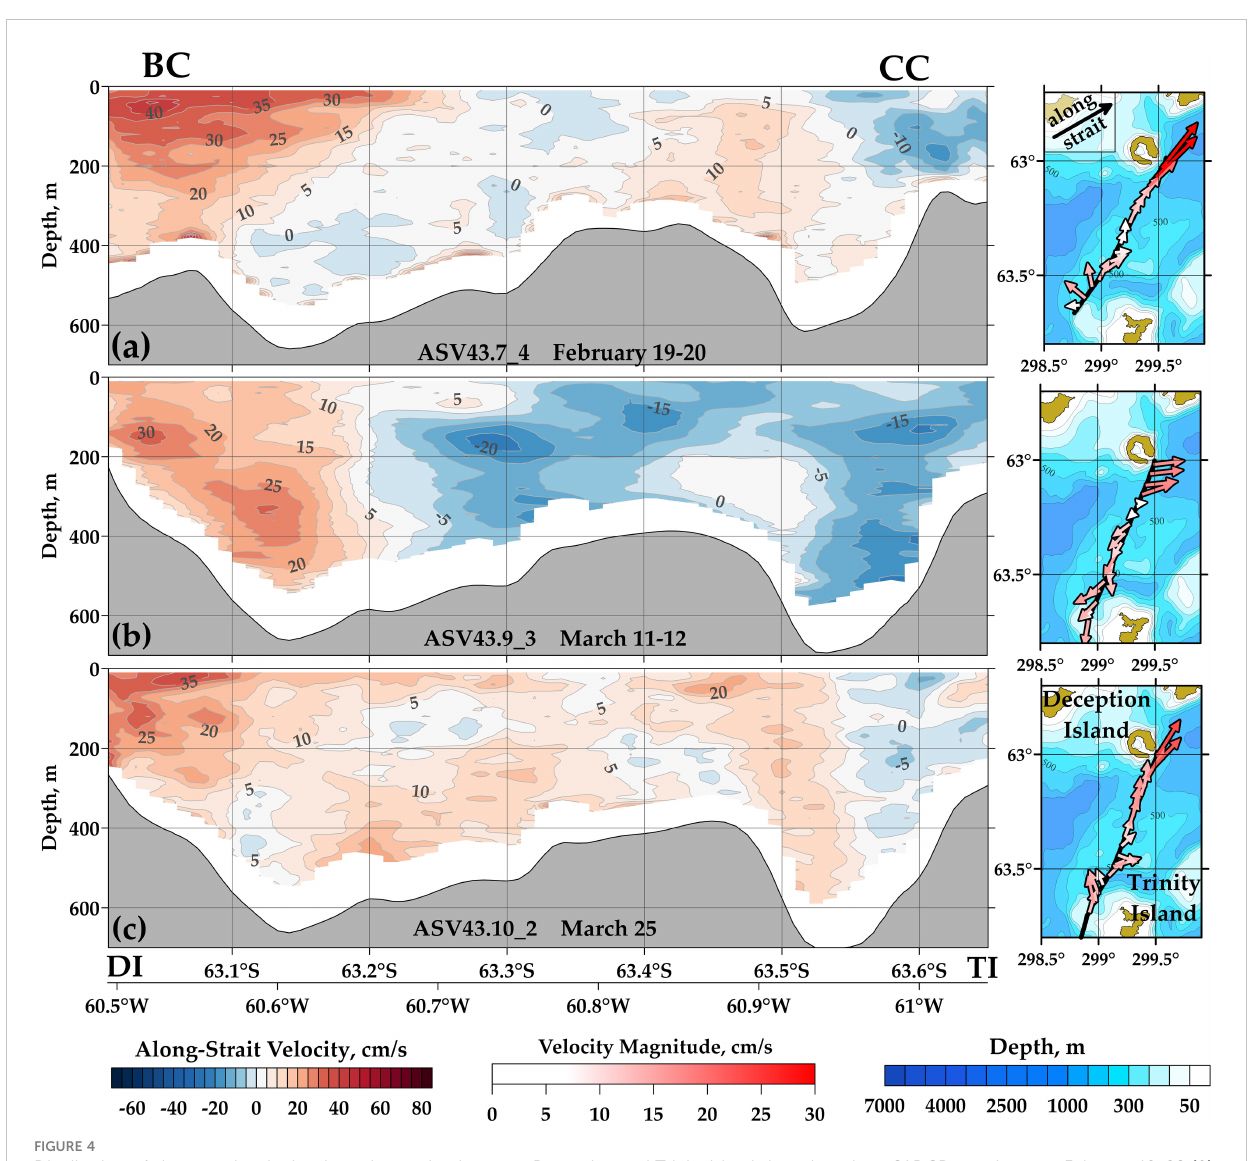
FIGURE 4 Distribution of along-strait velocity along the section between Deception and Trinity islands based on three SADCP crossings: on February 19-20 (A) , March 11-12 (B) , and March 25 (C) , 2017. Positive values of velocity correspond to the east-north-east direction (the exact value is 60° relative to the north; this direction is shown by black arrow in the upper right panel). The velocities were projected to the direction along the strait independently on the orientation of transects. Locations of the crossings are shown in the right panels together with the depth-averaged SADCP velocities. Ocean bottom is shown by grey color. DI, Deception Island; TI, Trinity Island; BC, Brans fi eld Current; CC, Antarctic Coastal